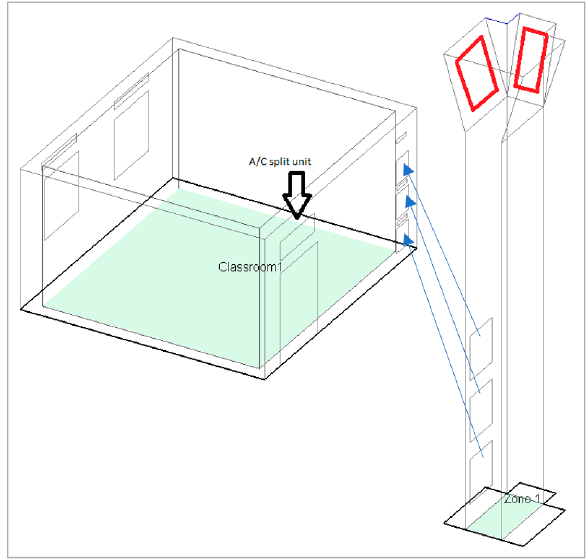
Figure 8. Modified classroom with a wind catcher.